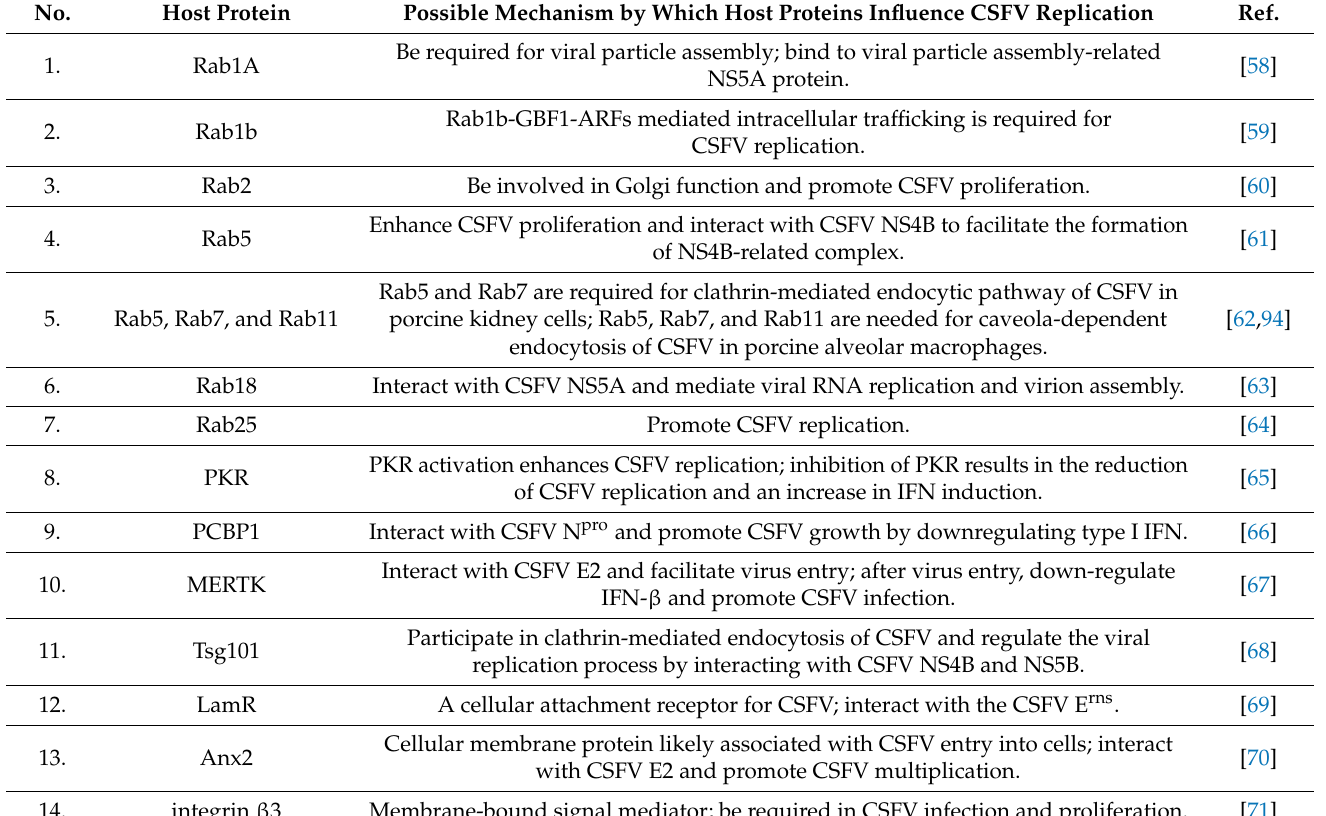
Table 2. Host proteins whose function defect can exert anti-CSFV